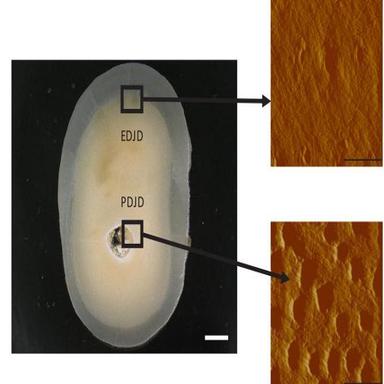
A representative light scope image (scale bar = 1 mm) and atomic force microscopy observation (scale bar = 10 µm) of a cross-sectioned tooth sample used in this study. Two target dentin areas – 500 µm below the enamel–dentin junction (EDJD) and 500 µm above the pulp–dentin junction (PDJD) – were assessed.